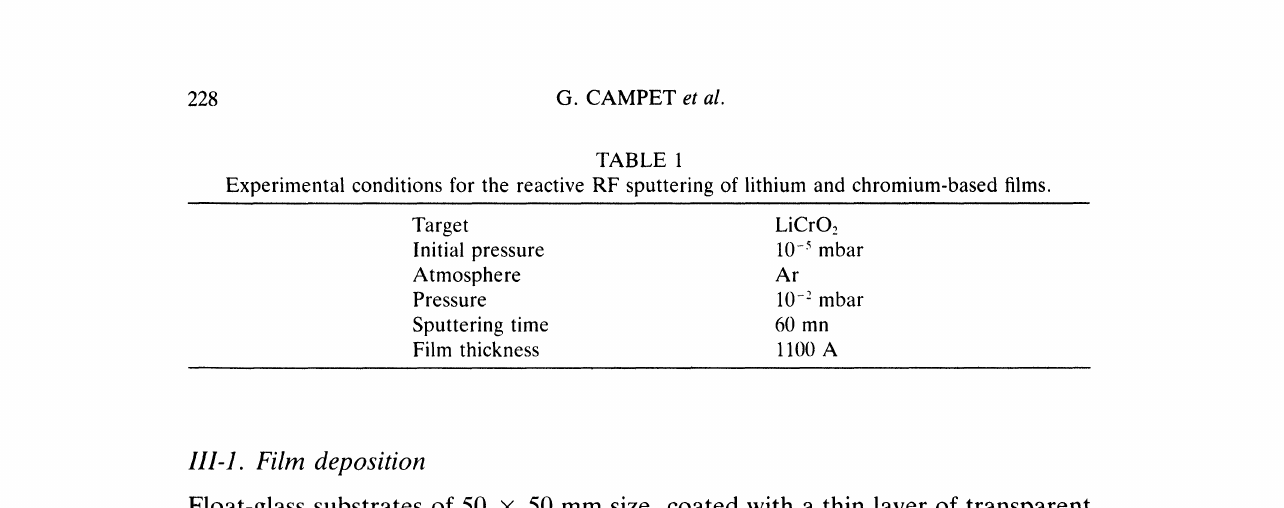
Experimental conditions for the reactive RF sputtering of lithium and chromium-based films.